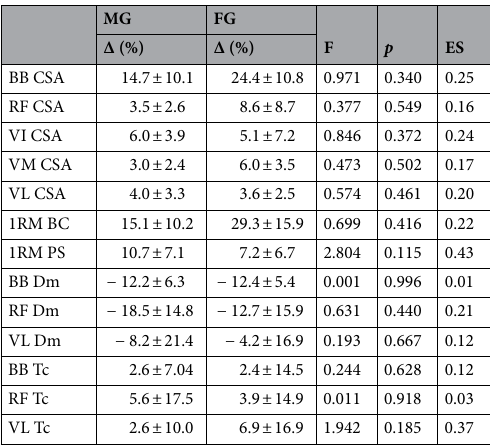
Table 3. ANCOVA output for relative sex-differences in tested variables using pre-test values as covariates. MG males group, FG females group, CSA cross-section area, 1RM one-repetition maximum, Dm radial displacement, Tc contraction time, BB biceps brachii, RF rectus femoris, VI vastus intermedius, VM vastus medialis, VL vastus